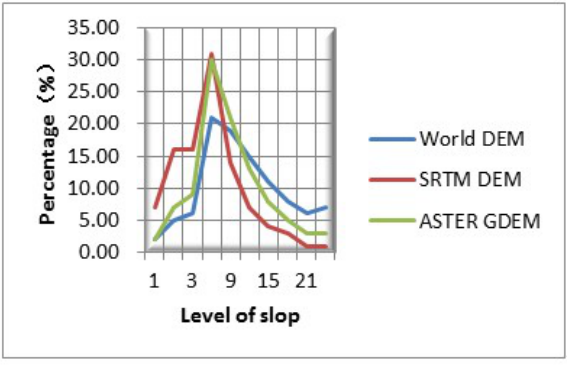
Figure 6 Slope spectrum of three DEMs in test area